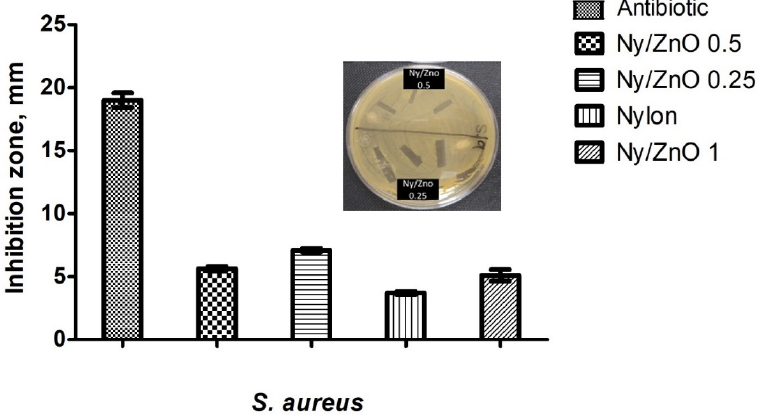
Figure 4. Effect of control samples, antibiotic, nylon, Ny/ZnO 1, Ny/ZnO 0.5, Ny/ZnO 0.25 on the growth of S. aureus .